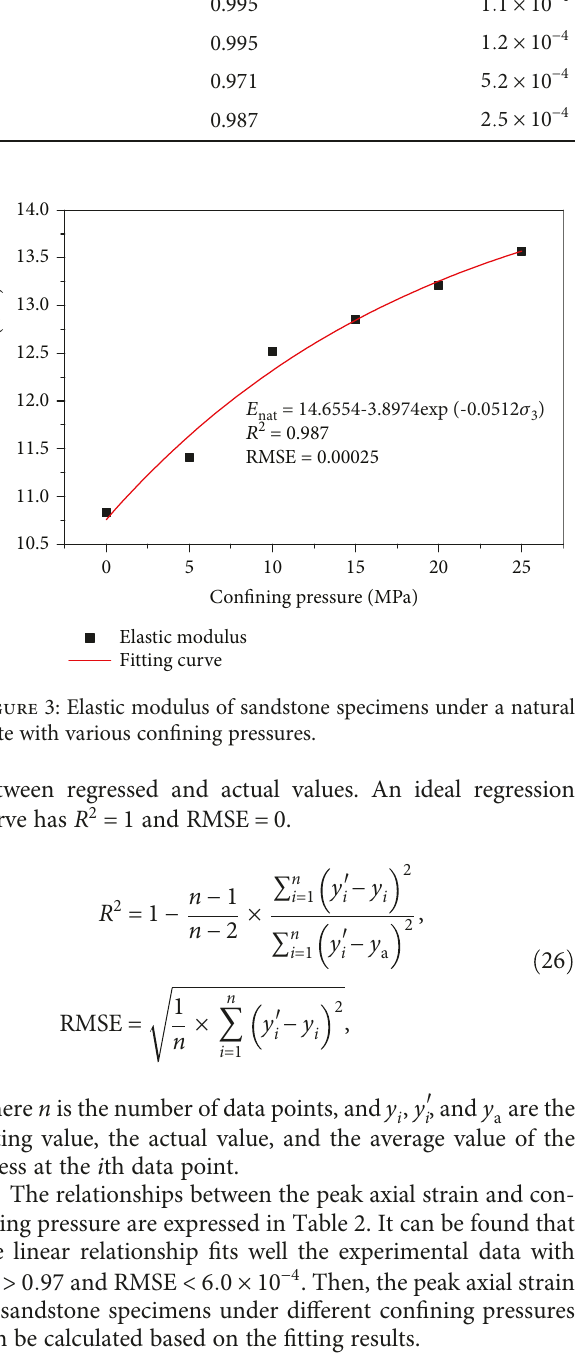
Table 2: Regression results of peak axial strain versus con fi ning pressures of sandstone treated with di ff erent chemical corrosions. Chemical environment